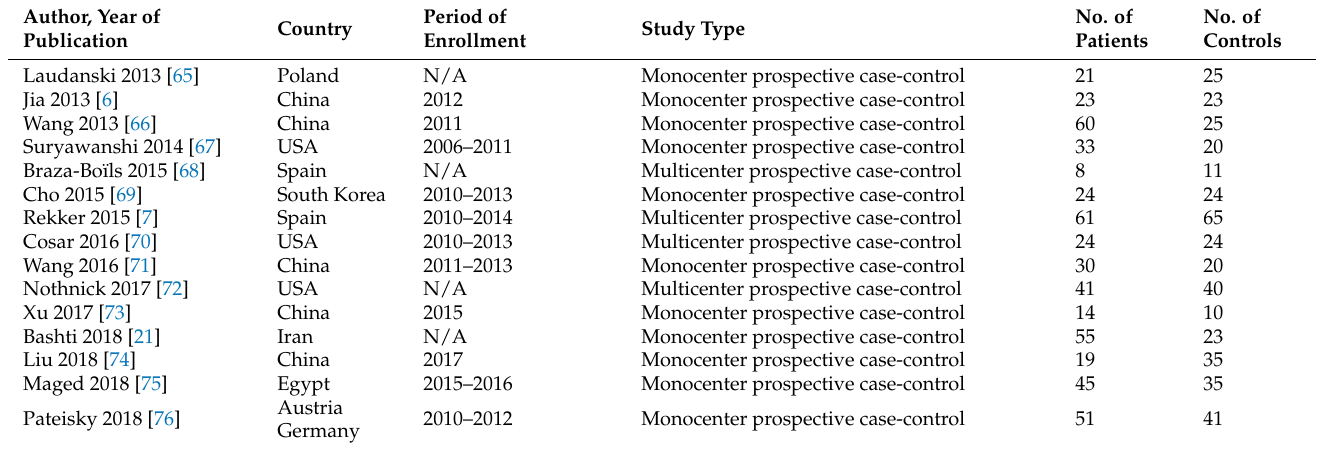
Table 1. Characteristics of included